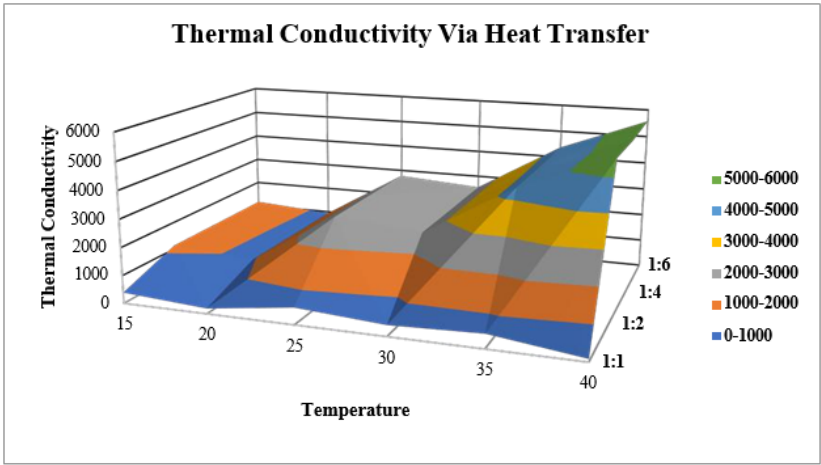
Figure 13. Mathematical model of thermal conductivity of ZVI-NPs at a particular temperature range Figure 13 . Mathematical model of thermal conductivity of ZVI - NPs at a particular temperature range of (1 5– 40 °C) along with the solvent mixing at 1:1, 1:2, 1:4 , and 1:6. of (15–40 ◦ C) along with the solvent mixing at 1:1, 1:2, 1:4, and